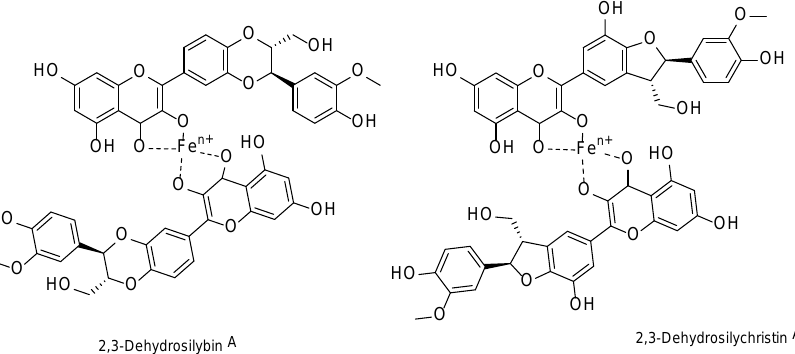
Figure 12. Plausible structures of the complexes of 2,3-dehydrosilybin and 2,3-dehydrosilychristin with iron.